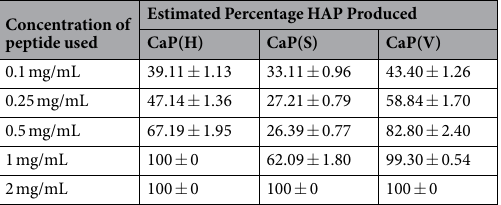
Table 1. Calculated percentage mass of HAP in each precipitate.